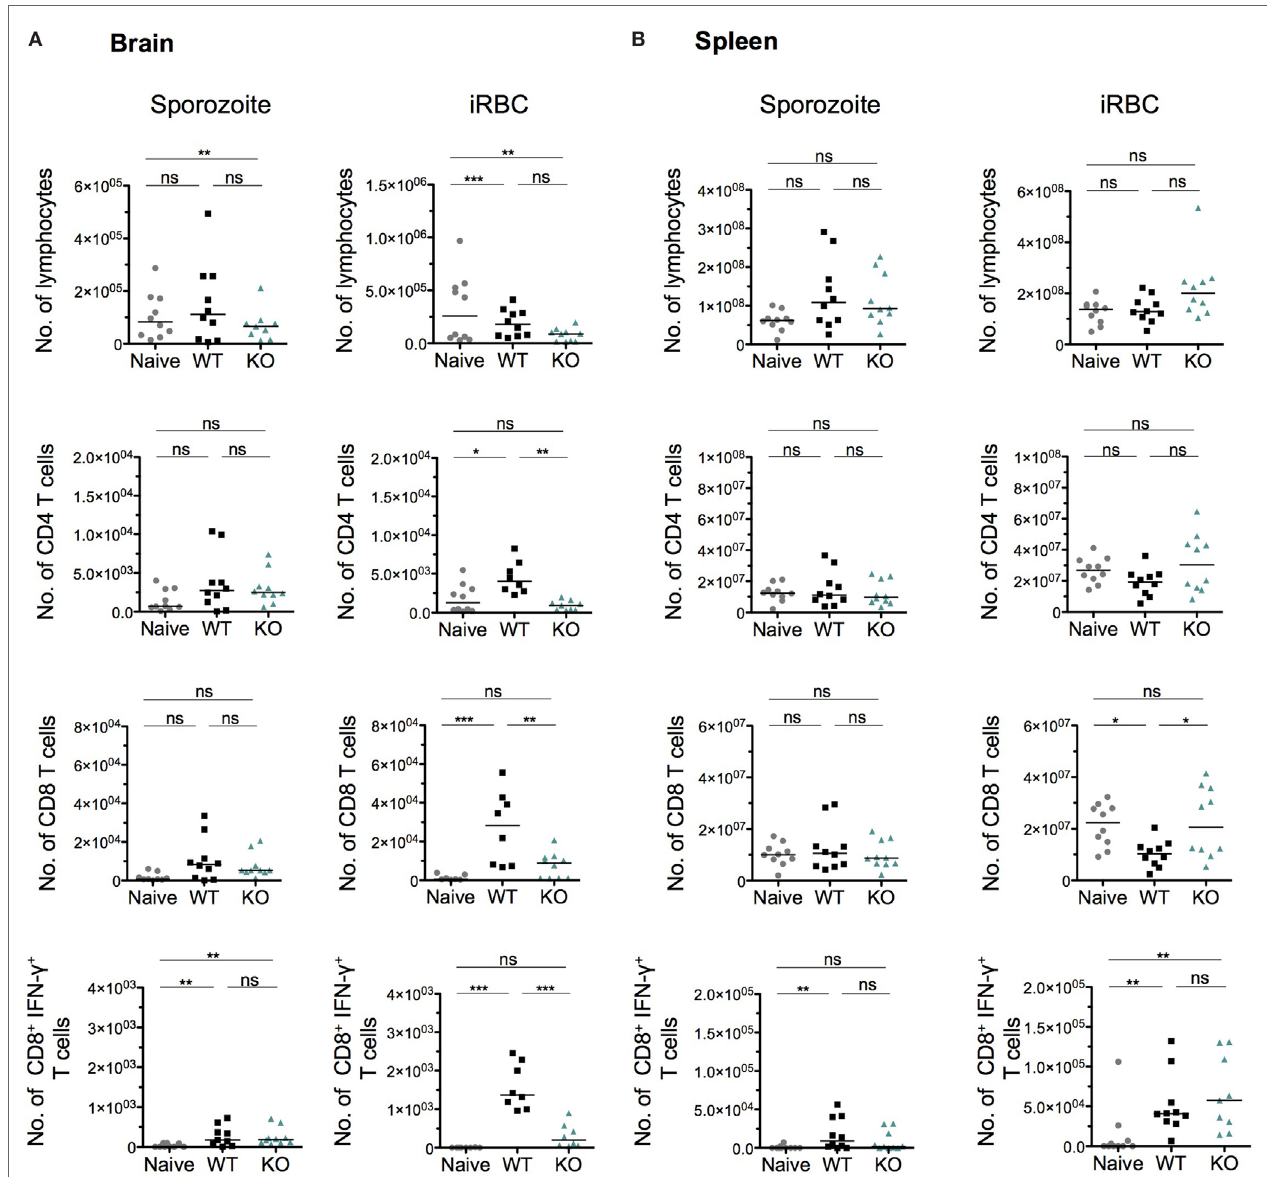
FigUre 7 | The immune status in spleen and brain is indistinguishable between Pb ANKA WT and PbmaLS_05 ( − )-infected mice after sporozoite injection, but significantly differs after infected red blood cell (iRBC) infection. Groups of five mice were infected with either WT or KO sporozoites and sacrificed on day 8 p.i along with five naïve mice. A separate set of mice were infected with WT or KO iRBCs and sacrificed on day 5 p.i. along with five naïve mice. Lymphocytes isolated from brains (a) and spleens (B) were stimulated ex vivo with Pb1 and stained with CD8, CD4, and IFN- γ antibodies for quantification and phenotypic analysis by flow cytometry. Each data point represents cell numbers isolated from one individual mouse and the results shown with median are pooled data from two independent experiments. Statistical significance was determined by Kruskal–Wallis test with Dunn’s multiple correction or One-way ANOVA with Bonferonni’s adjustment (*** p < 0.0001, ** p < 0.001, and * p < 0.01; ns, not